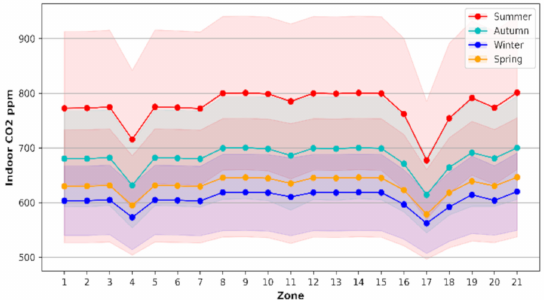
Figure 15. CO 2 concentrations mean per season (hues account for standard